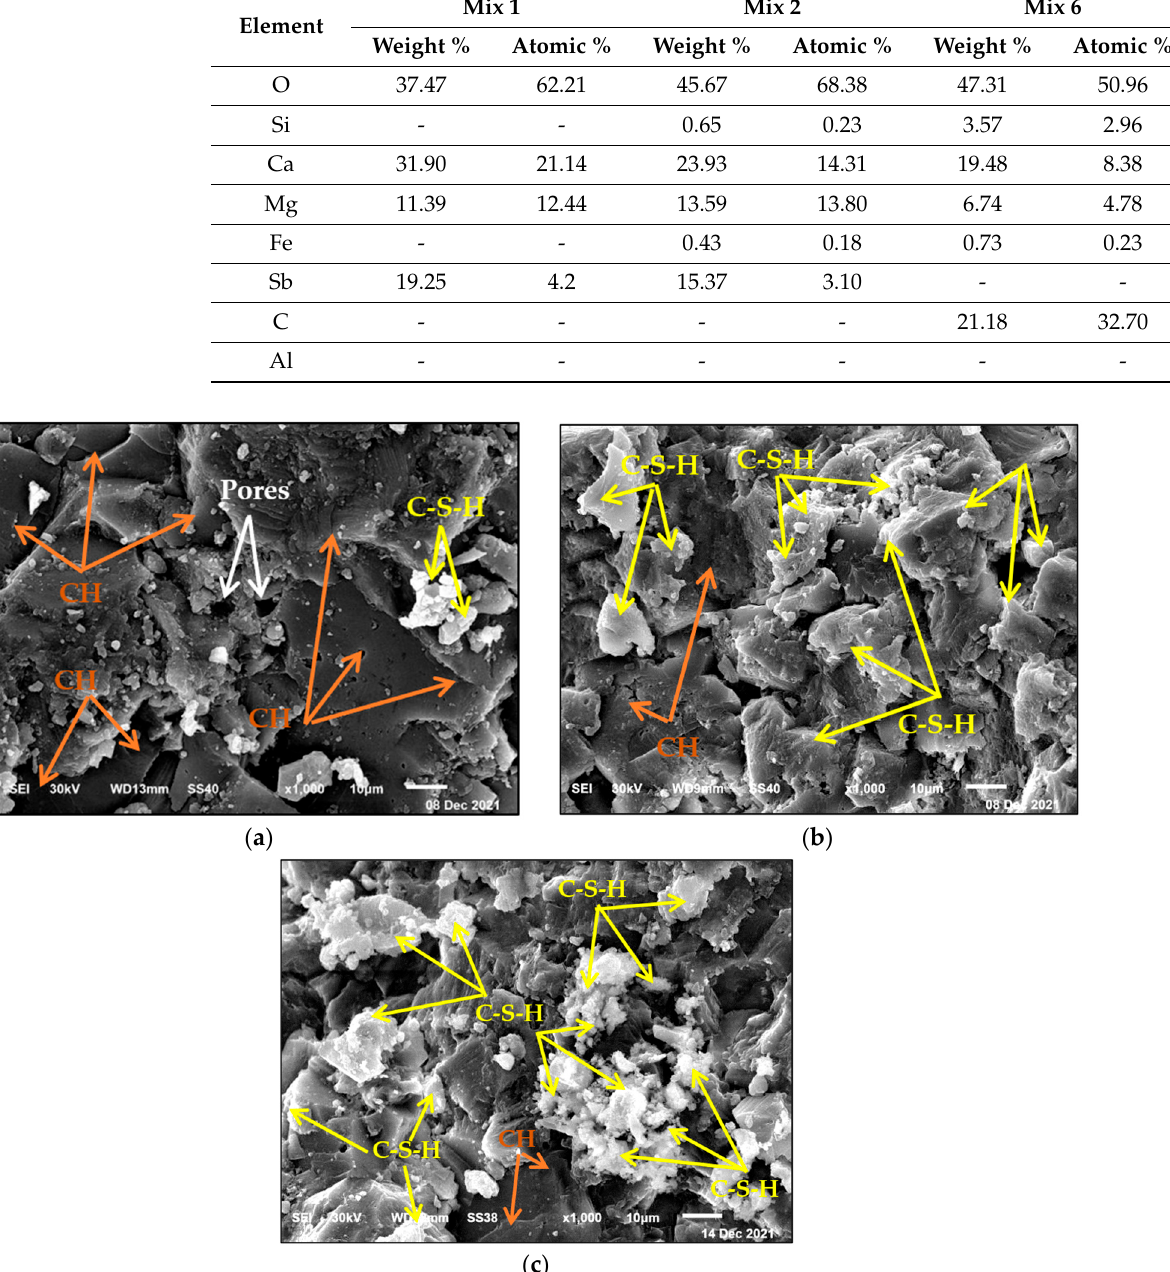
Table 7. EDX analysis results.